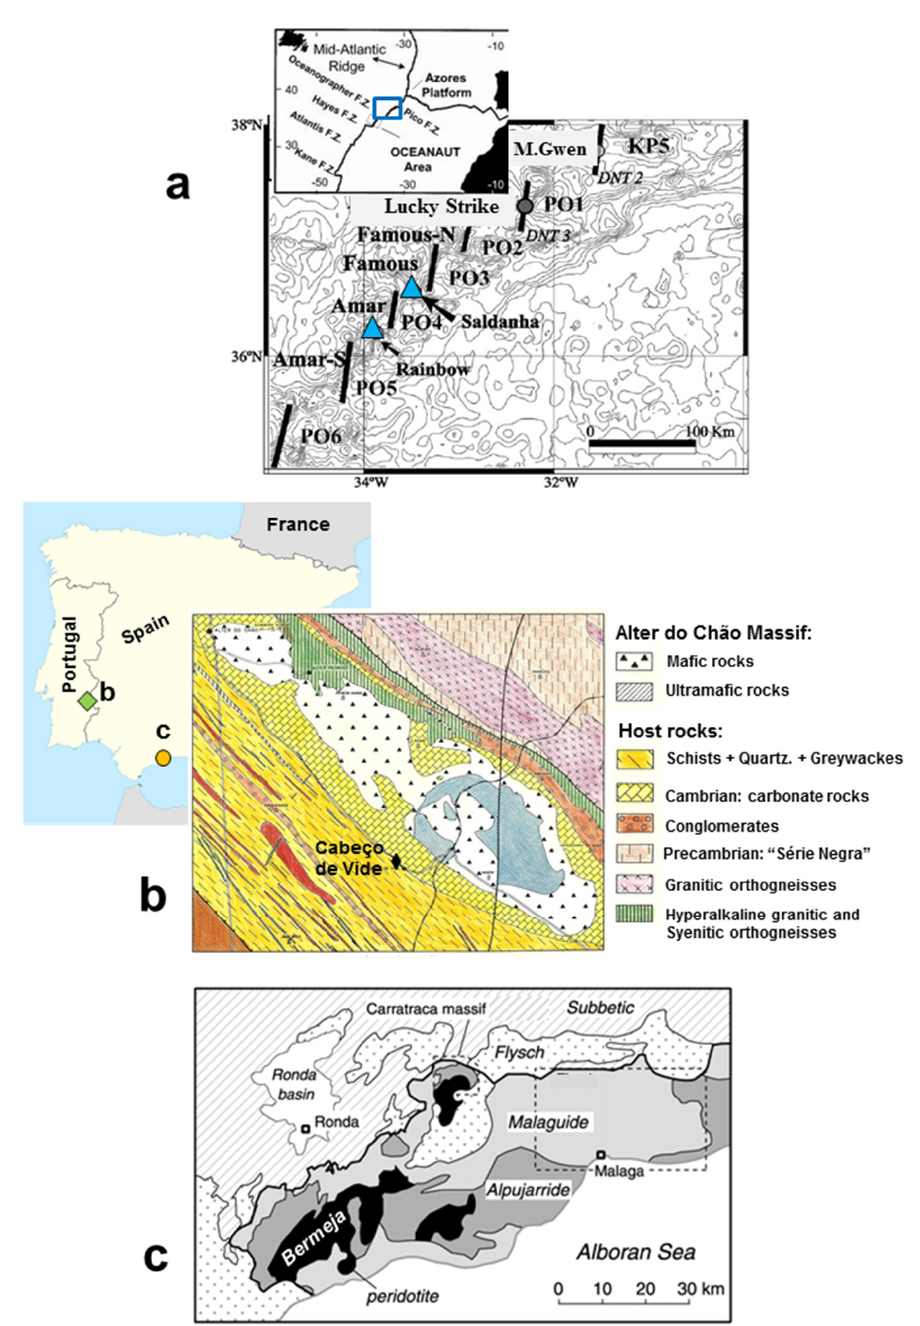
Figure 1. Location of the studied settings: ( a ) the Rainbow and Saldanha hydrothermal sites, in the Azores sector of the Mid-Atlantic Ridge [18,20]; ( b ) AC1 and AC2 boreholes (drilled by A. Cavaco Co.), in the Cabeço de Vide village, in the Alter do Chão mafic-ultramafic massif, NE Alentejo, Portugal (adapted from [31]); ( c) the Bermeja Formation of the Ronda Massif in the Betic Cordillera, SW Spain (adapted from [35]).